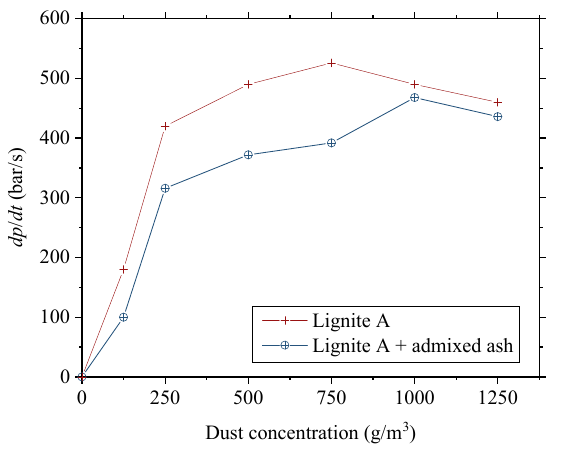
Figure 3. The rate of pressure rise for Lignite A with a 5% and a 15% ash content.